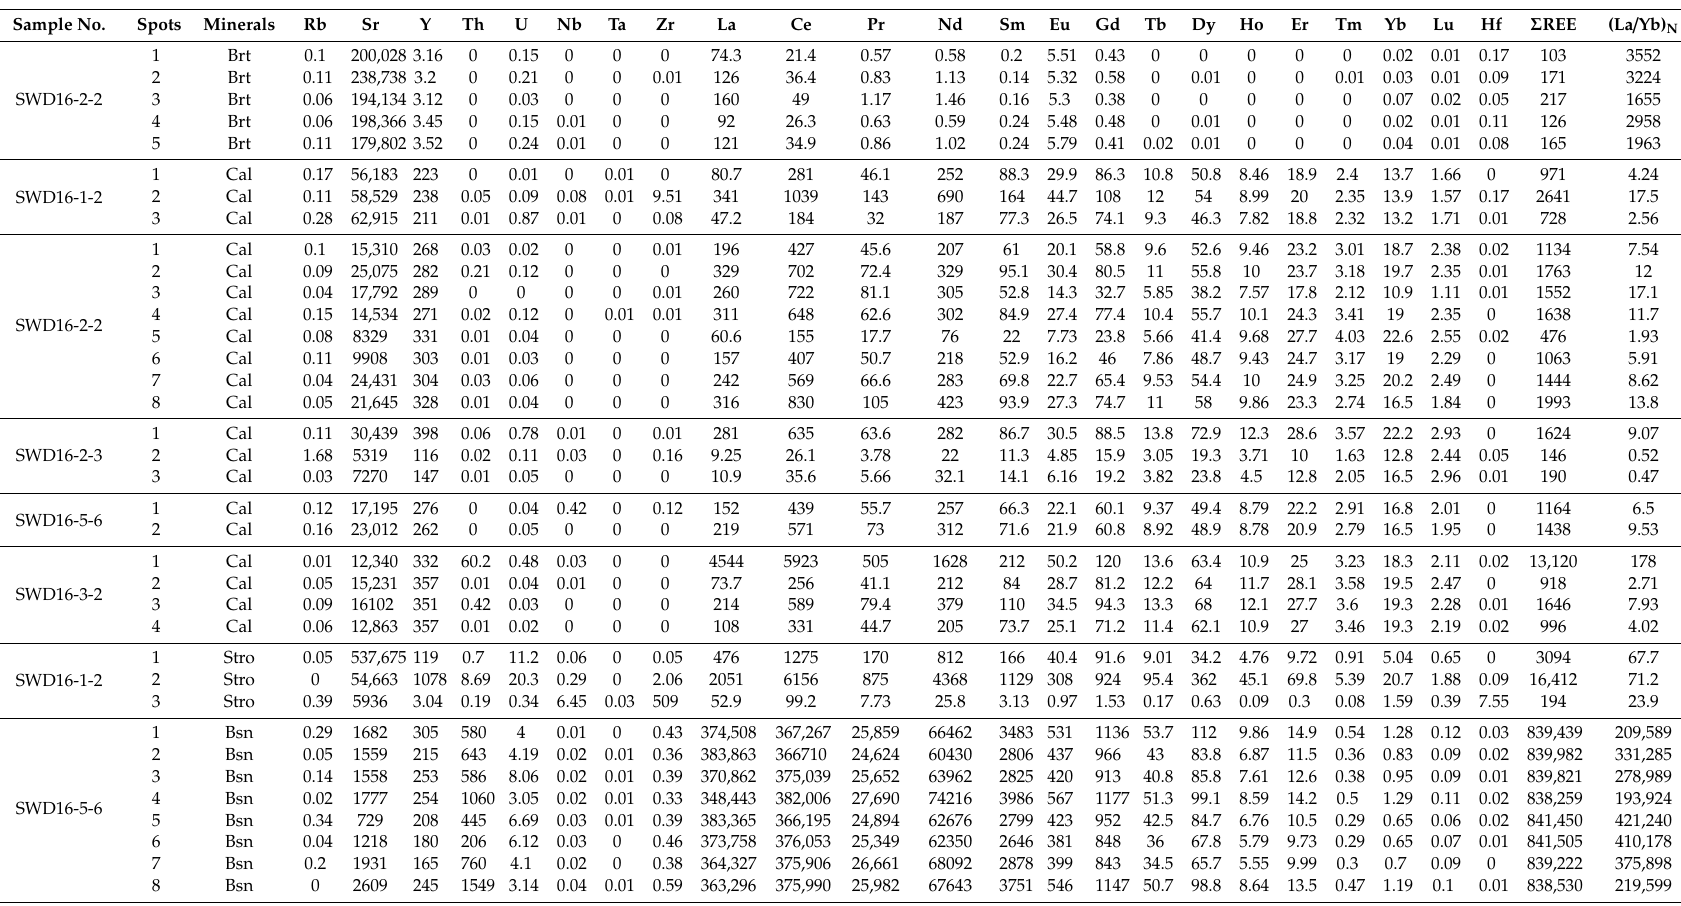
Table 6. Results of LA-ICP-MS analyses (in ppm) of barite, calcite, strontianite, bastnäsite, and monazite from typical REE ores in the Weishan deposit. Sample